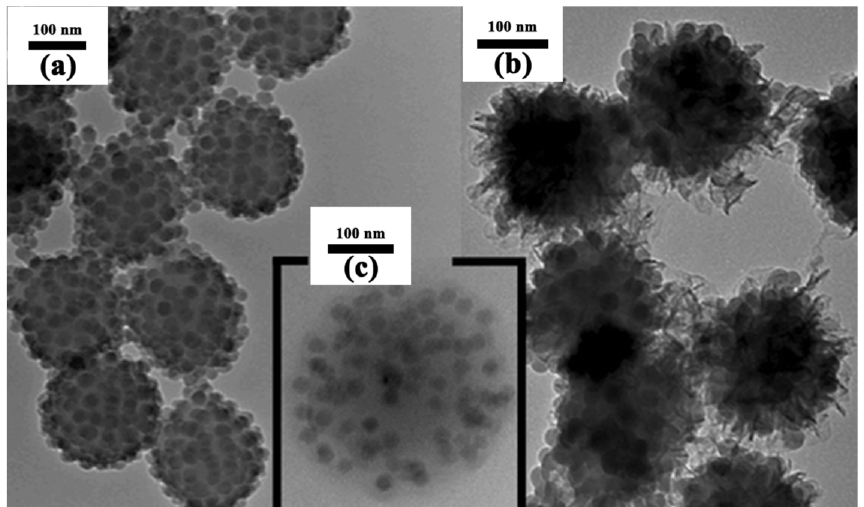
Figure 3. TEM images of ( a ) PMMA latex armored with SiO 2 nanoparticles obtained by Pickering emulsion polymerization. Multilayered nanocomposite polymer colloids with ( b ) a “hairy” outer– layer of poly(acrylonitrile) and ( c ) a soft shell of poly(n–butyl acrylate). Reproduced from [43] with permission from the American Chemical Society.